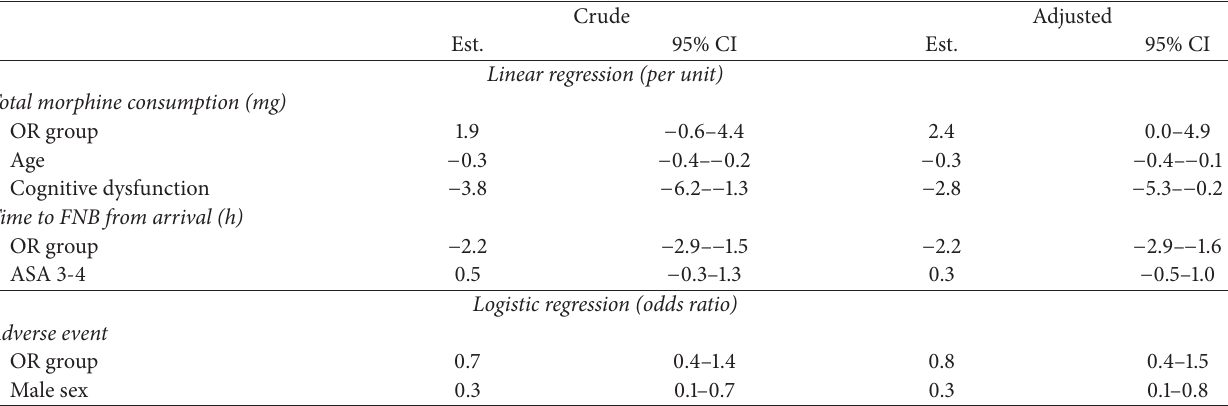
Table 2: Linear and logistic regression analyses with crude and adjusted outcomes. Potential confounders adjusted for are age, sex, ASA class, and cognitive dysfunction. Only the exposure variable (group) and confounders with 𝑝 values ≤ 0.05 are